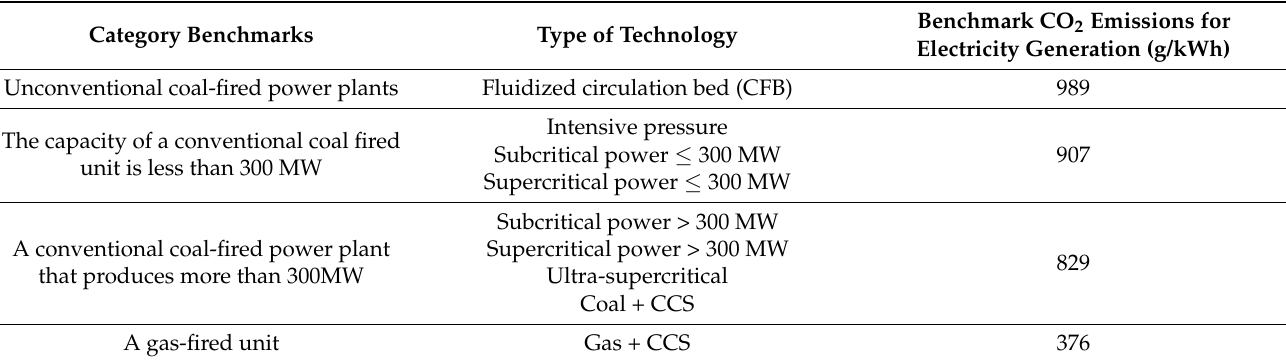
Table 3. CO 2 emissions benchmark design for